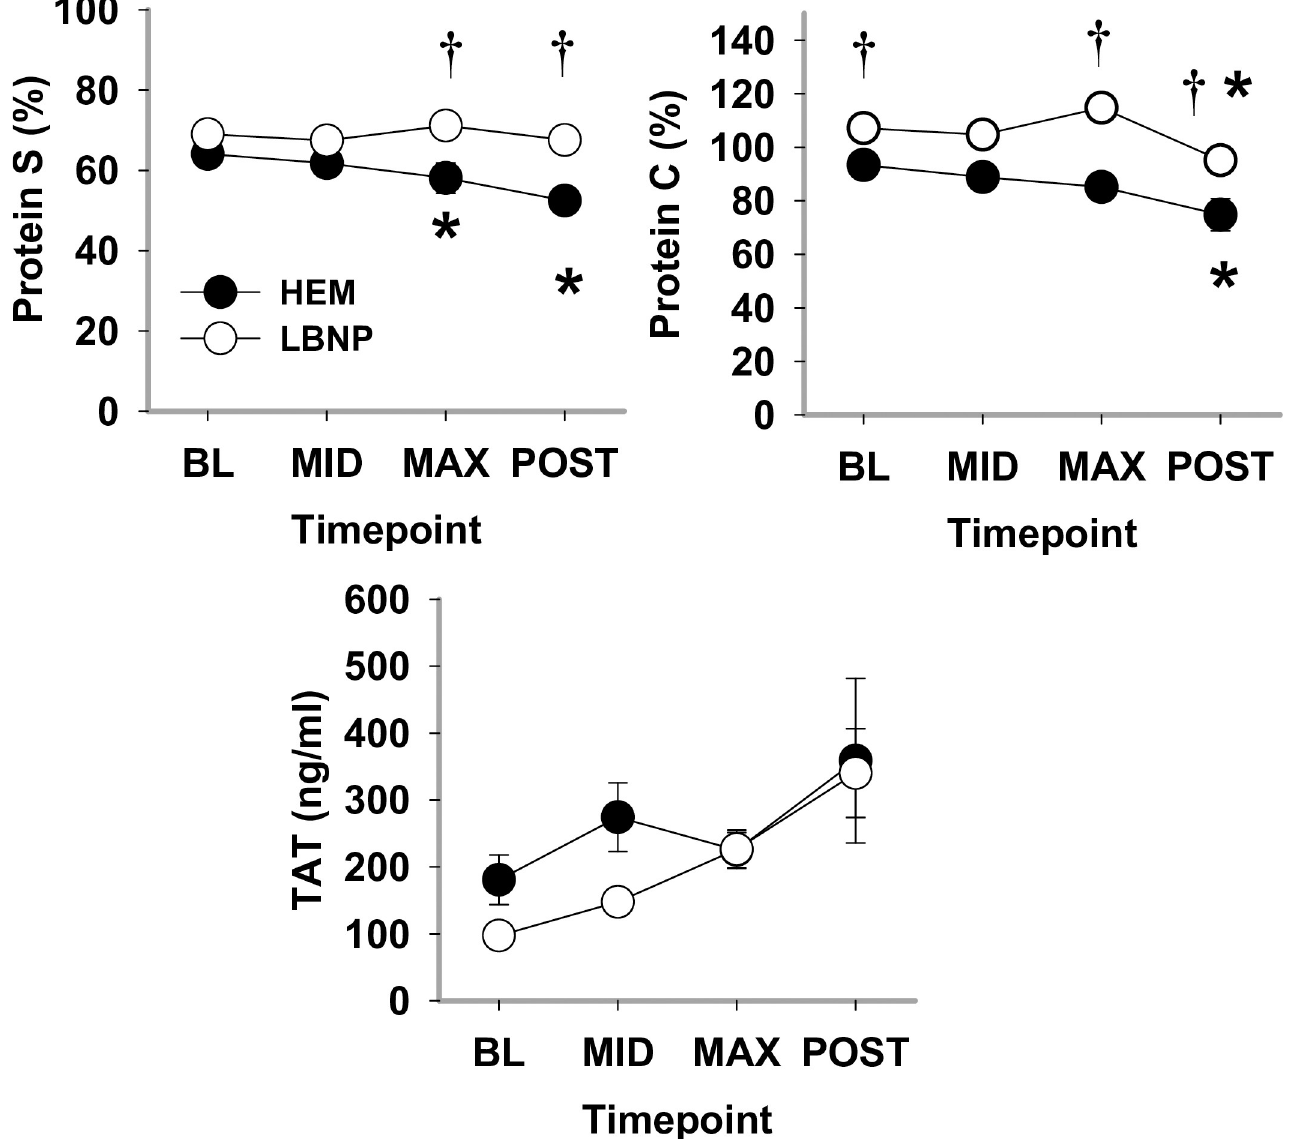
Fig 5. Plasma anti-coagulant protein C activity, protein S activity, and thrombin-antithrombin III complex (TAT) during HEM and LBNP in anesthetized baboons. Mean ± SE, n = 11–13; � different from baseline ( P < 0.05); and † different from blood removal ( P < 0.05).